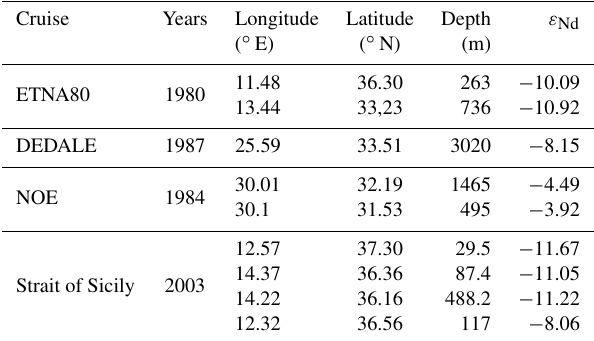
Table 1. Coordinates of the studied cores together with water